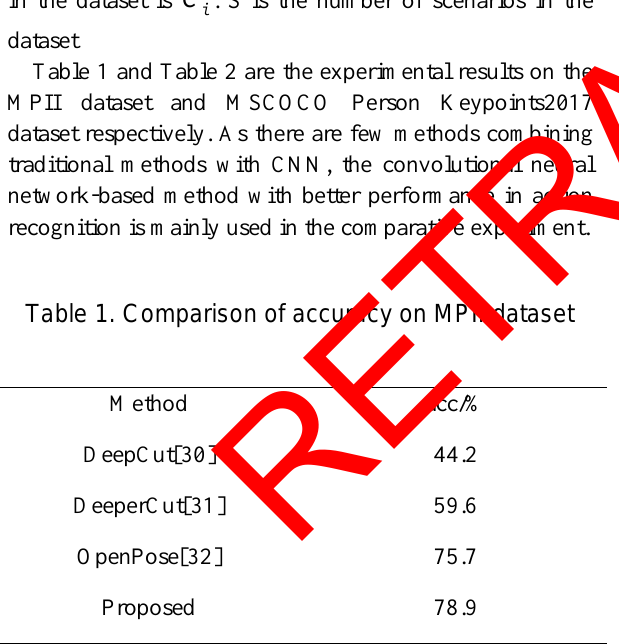
Figure 7. Confusion matrix on MPII